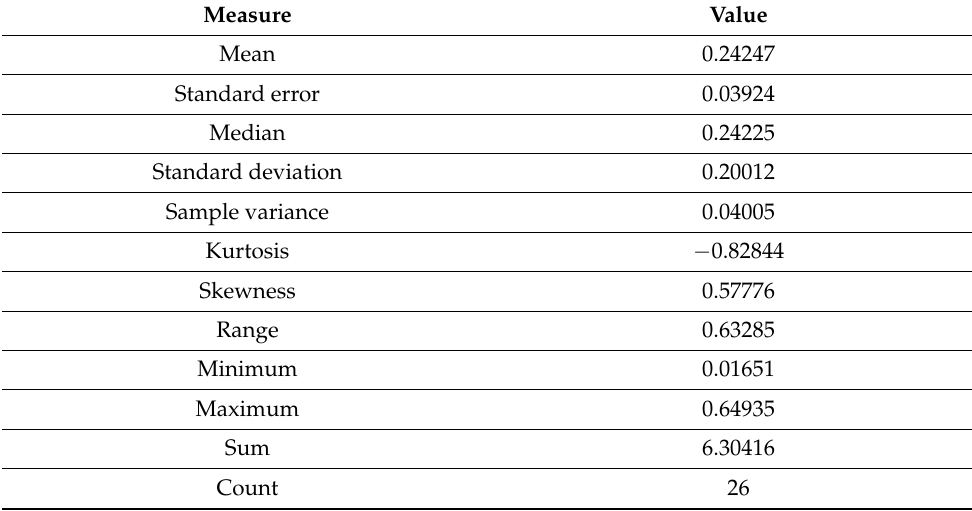
Table 1. Descriptive statistics of DRs in 2020 (26 EU member states).